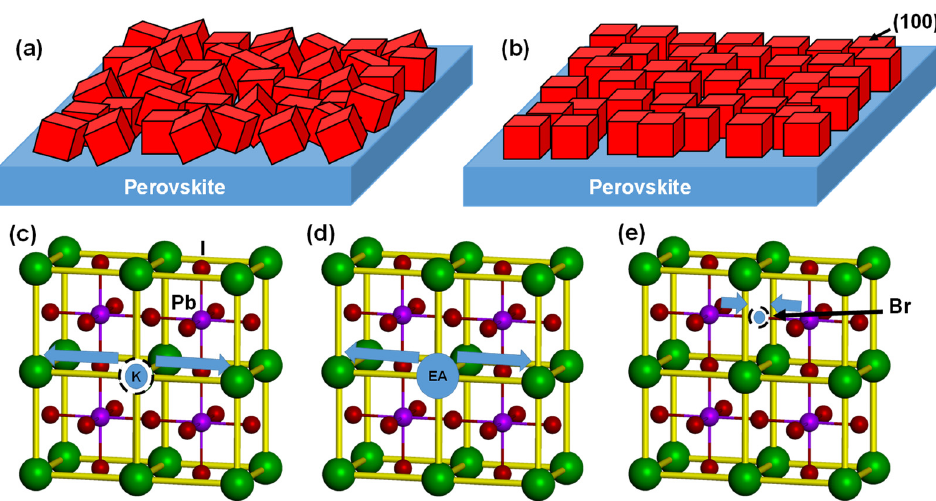
Figure 5. Schematic models of ( a ) randomly and ( b ) (100)-oriented perovskite grains. Changes in perovskite lattice due to the introduction of ( c ) K, ( d ) EA, and ( e ) Br. Band structures and the partial density of states of the MAPbI 3 and MA 0.625 EA 0.25 K 0.125 PbI 2.5 Br 0.5 perovskite crystals were calculated from the first-principles